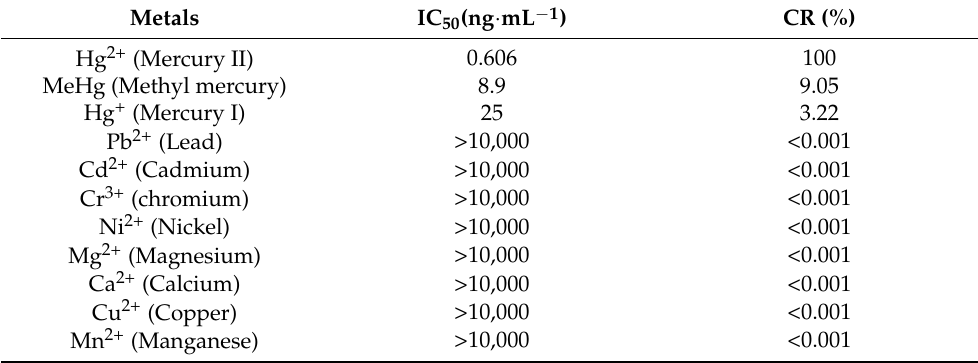
Table 1. The cross-reactivity of mAb against mercury with Hg 2+ , Cu 2+ , MeHg, Pb 2+ , Cd 2+ , and other